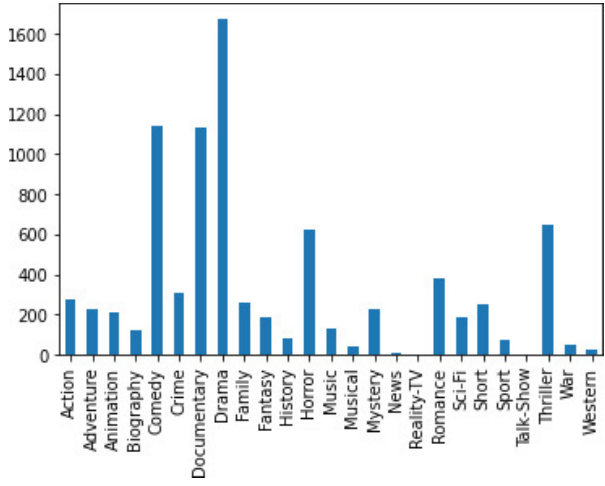
Figure 4. Number of movies by genre in the dataset.